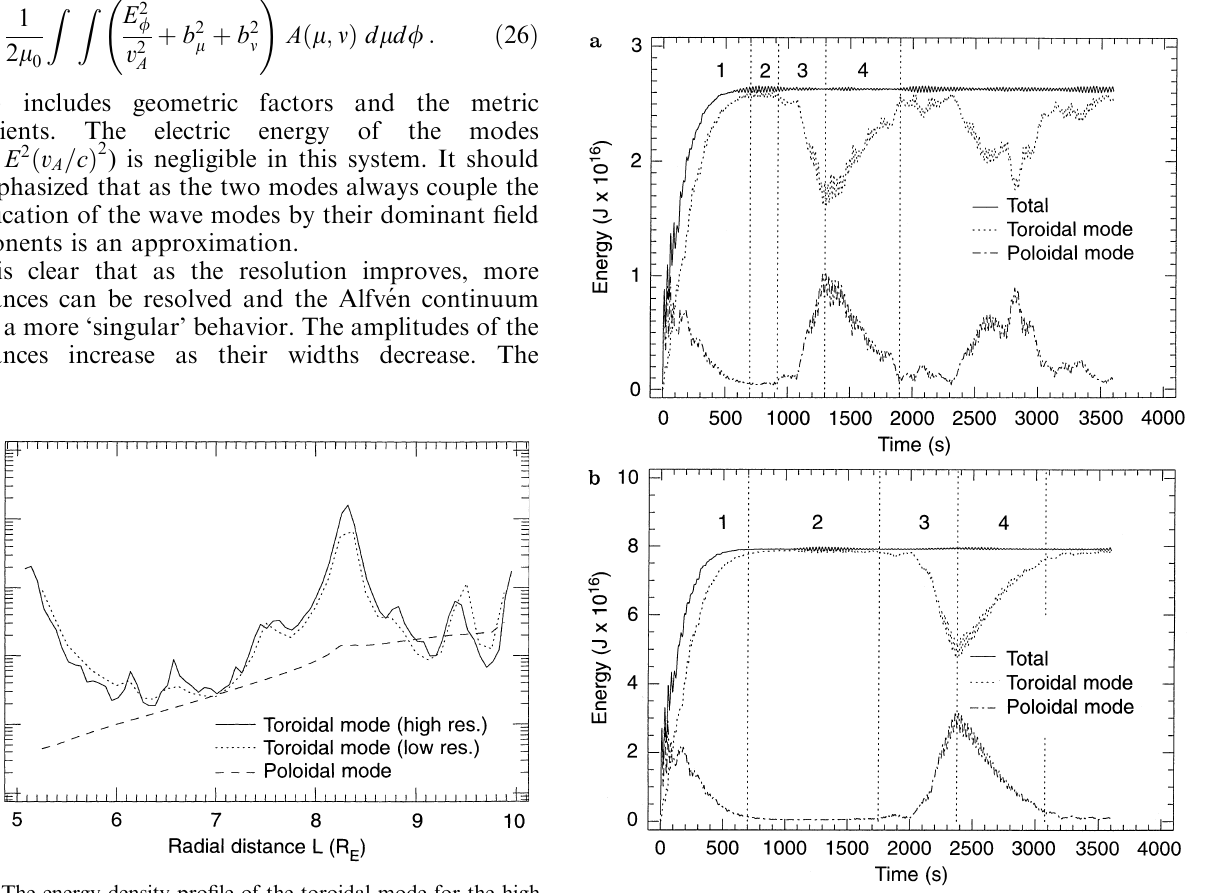
Fig. 4a,b. The temporal development of the total energy of the system ( solid line ) and the energy of the toroidal mode ( dotted line )/poloidal mode ( dotted-dashed line ) in the a low resolution grid and b the high